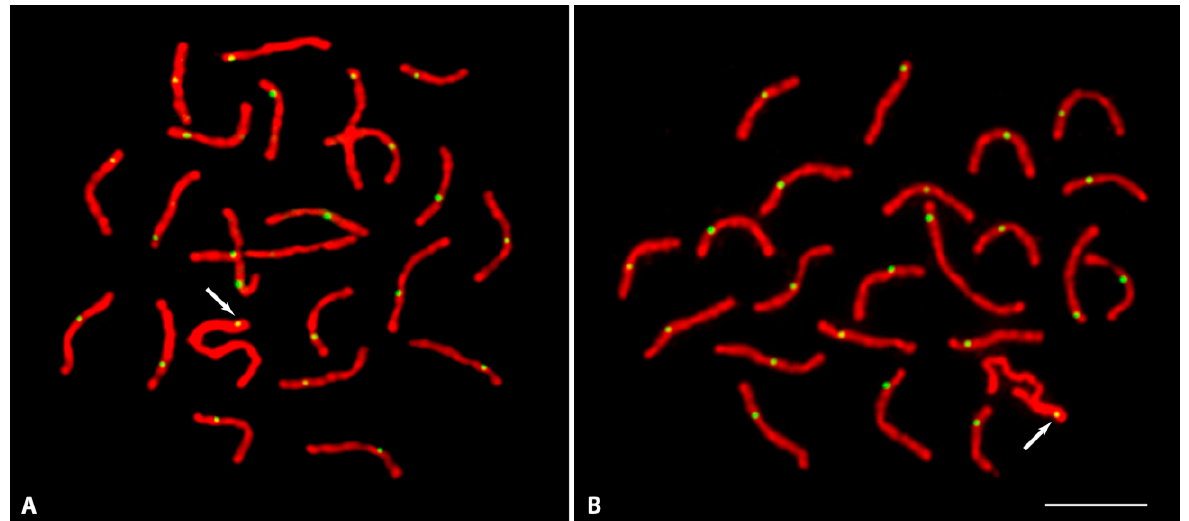
Figure 3. Meiotic spread of testis displaying complete set of autosomal synaptonemal complexes and the sex pair after immunolocalization of SYCP3 (red) and MLH1 (green) at pachytene stage. The green MLH1 specific spot on each synaptonemal complex points to the recombination sites. The arrows